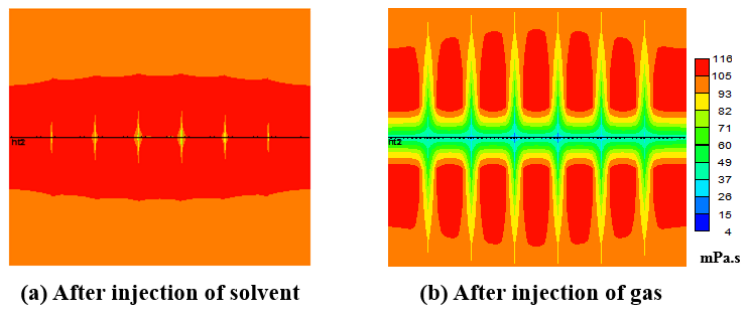
Figure 14. Variation in characteristics of crude oil viscosity at different timing.